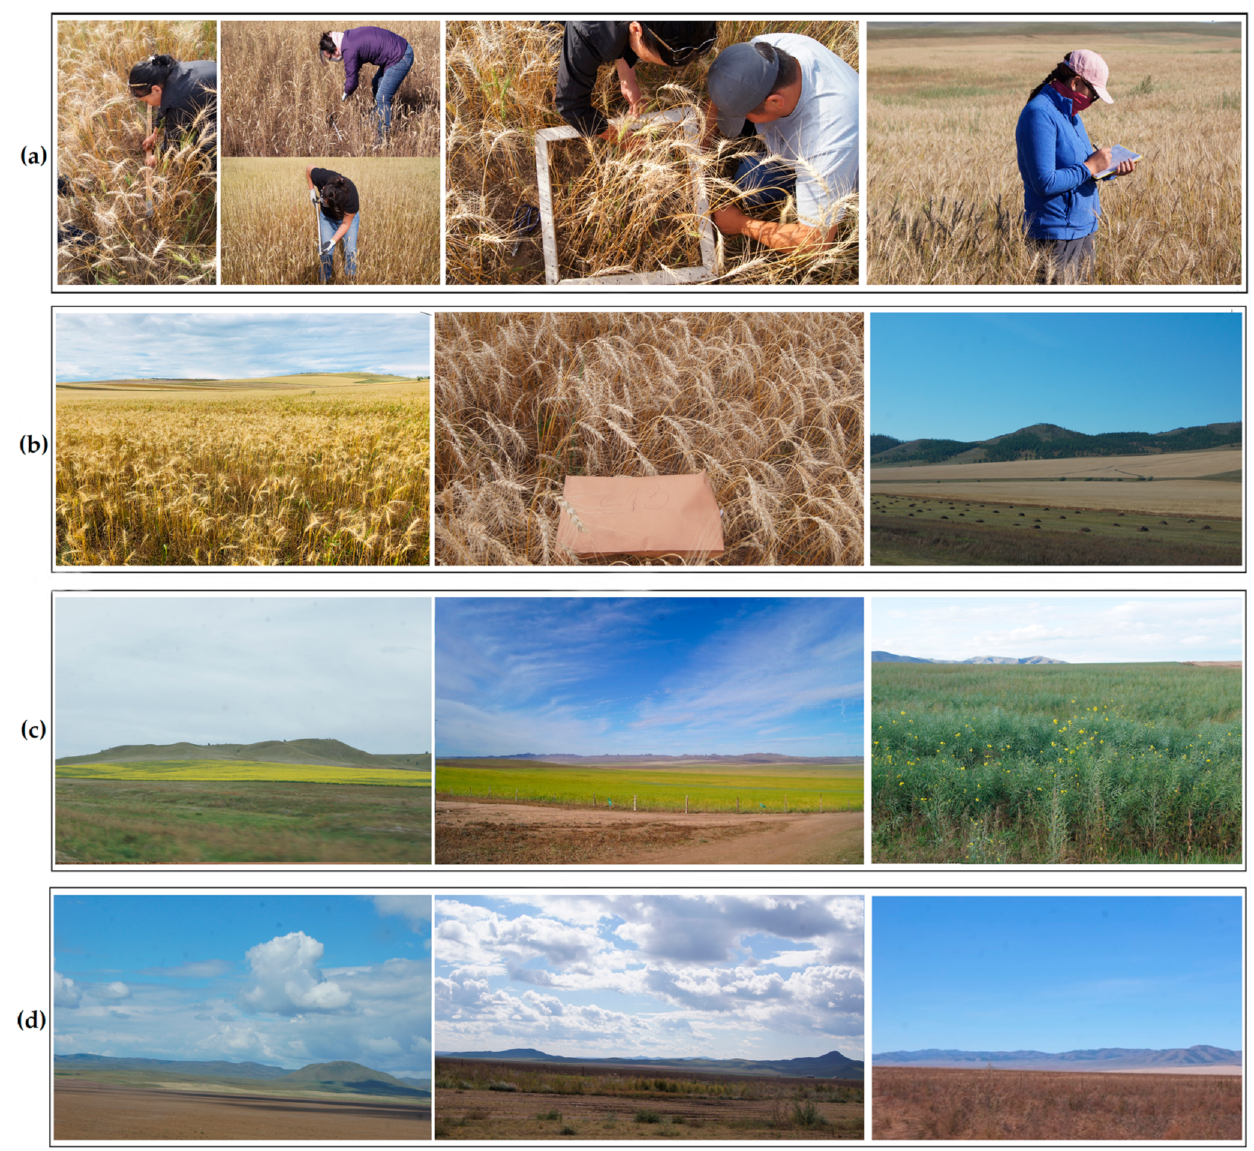
Figure 4. Glimpses of field measurements. ( a ) field measurement; ( b ) field photographs of wheat; ( c ) field photographs of rapeseed; ( d ) field photographs of fallow